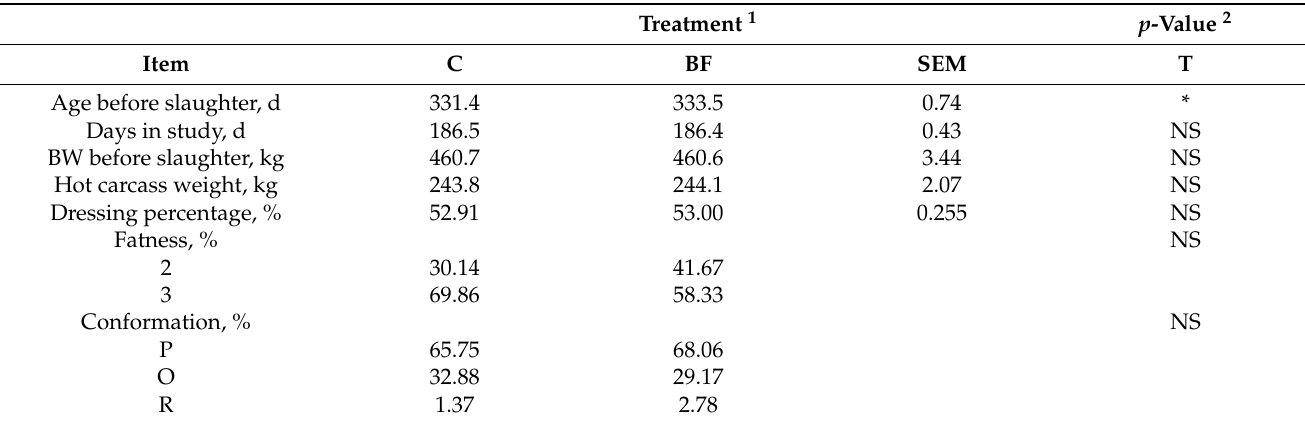
Table 3. Carcass quality from Holstein bulls fed high-concentrate diets supplemented with cit- rus flavonoids.